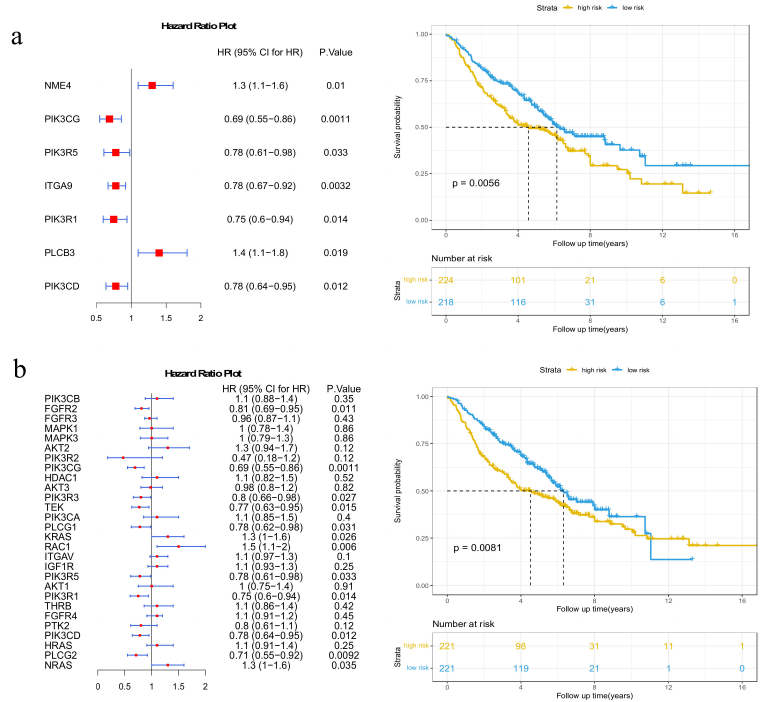
Figure 9. Results of survival analysis in GSE68465. ( a ) Kaplan–Meier survival curves of patients classified into high-risk and low-risk groups using 7 genes that belong to the top 5 genes with the highest-degree potential disease genes; ( b ) Kaplan–Meier survival curves of patients classified into high-risk and low-risk groups using genes that belong to both the 28 top 5 high-degree and immune-related